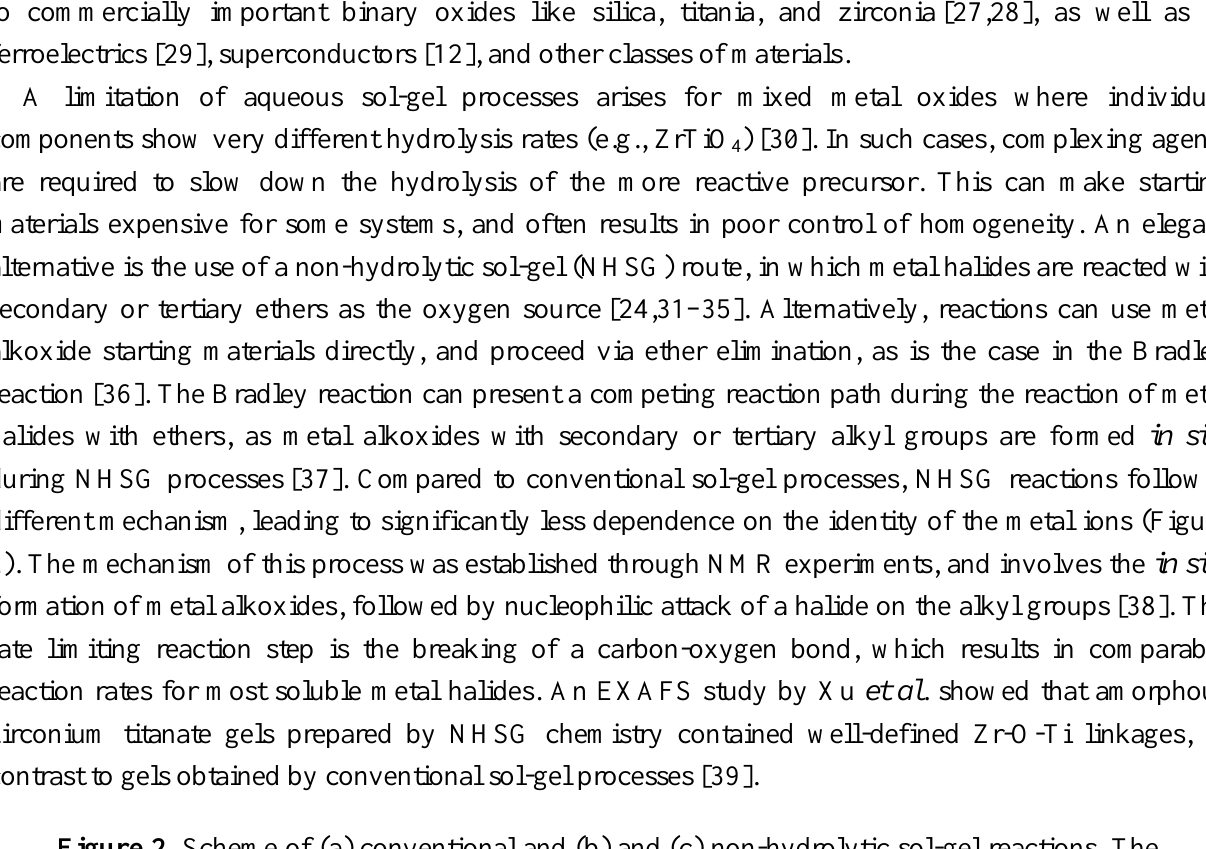
Figure 2. Scheme of (a) conventional and (b) and (c) non-hydrolytic sol-gel reactions. The reaction paths (b) and (c) show the mechanisms of NHSG reactions starting from metal halides, and the special case of the Bradley ether elimination reaction. Ch = chalcogenide (O, S), X =